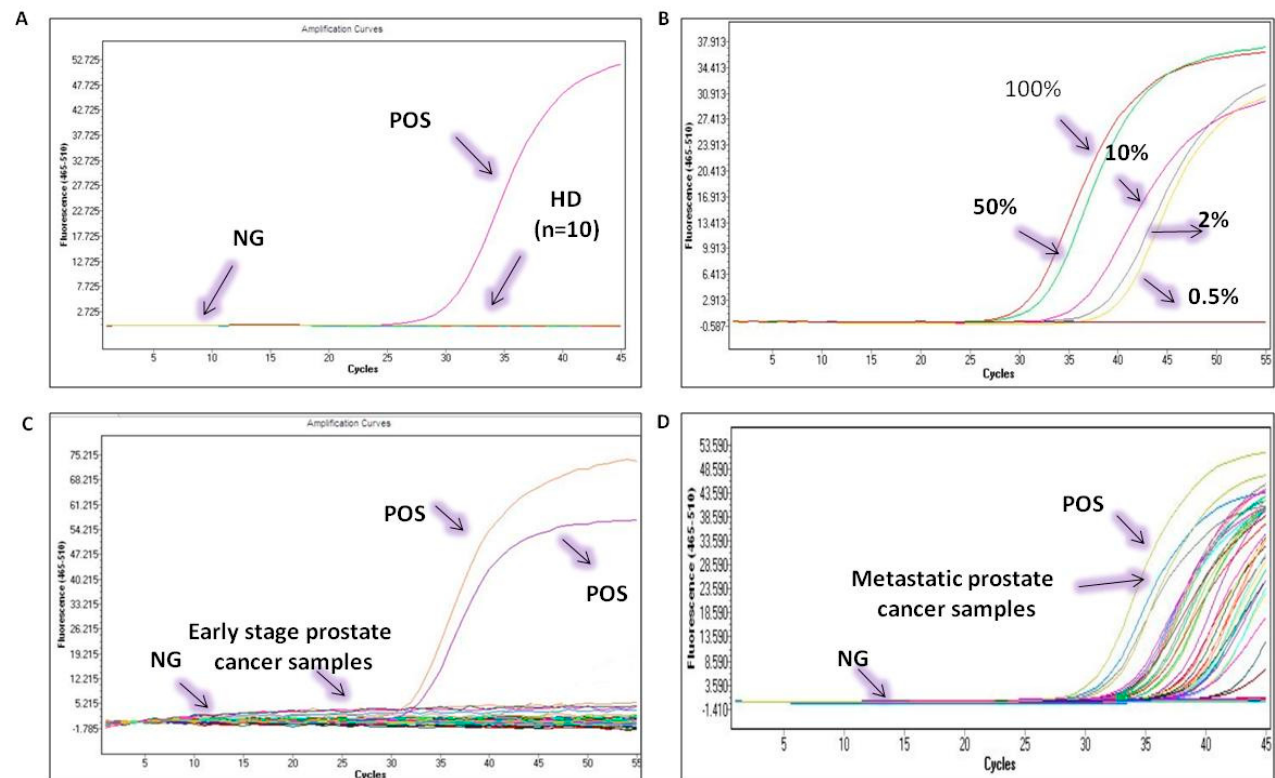
Figure 5. Analytical validation of the USP44 promoter methylation real time MSP assay. ( A ) analytical specificity, ( B ) analytical sensitivity, ( C ) USP44 RT-MSP in early-stage prostate cancer samples, ( D ) USP44 RT-MSP in metastatic prostate cancer samples.